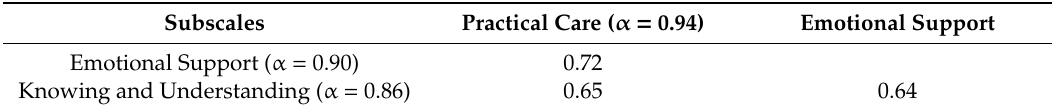
Table 5. Factor correlation matrix and